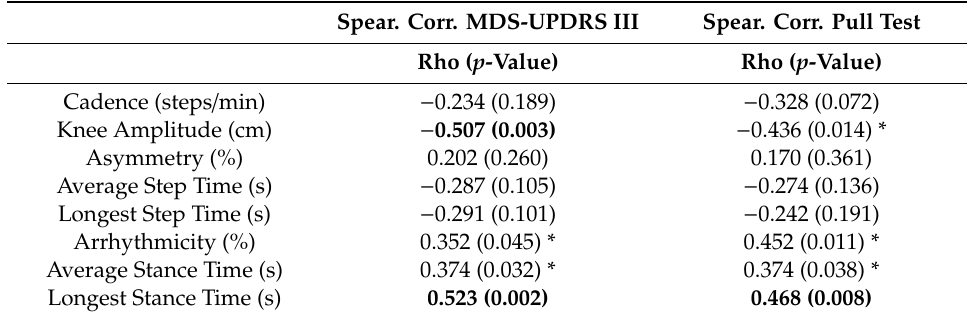
Table 4. Spearman’s rank correlation of the eight kinematic parameters with clinical ratings acquired at the time of each SIP recording; analyzed from the pooled dataset ( n =